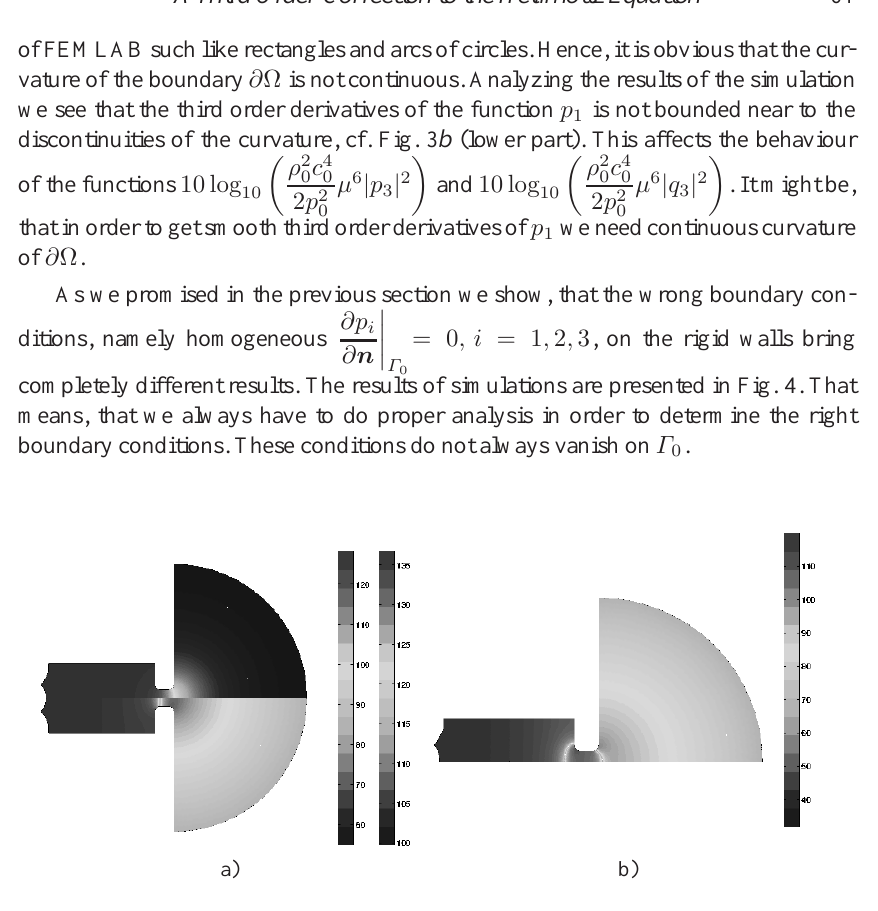
ρ 2 0 c 4 0 µ 2 | p 1 | 2 on the 2 p 2 0 „ «